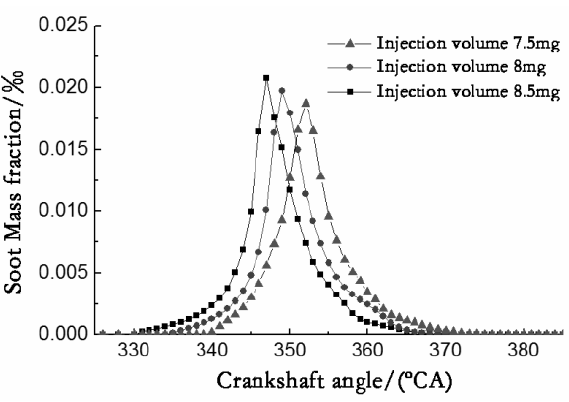
Figure 27. NO curves corresponding to different fuel injection volumes.